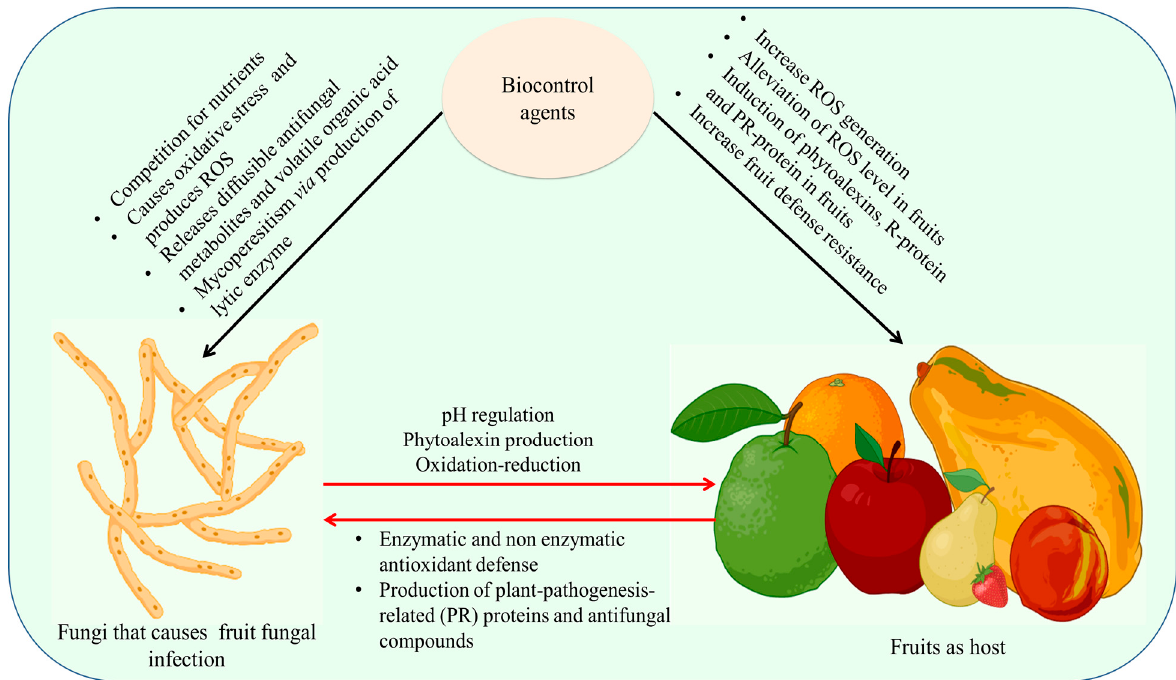
Figure 5. Mechanism of biocontrol mechanism in fruit and pathogen. The biocontrol agents affect fungal pathogens by causing oxidative stress that triggers ROS, releases diffusible antifungal me- tabolites and volatile organic acid and Mycoperesitism via the production of lytic enzyme. In fruits, increase ROS generation, induction of phytoalexins, R-protein, and PR-protein in fruits led to an increase in fruit defense resistance by antioxidant enzymes. Figure created with BioRender.com (https://app.biorender.com/biorender ‒ templates)—accessed on 25 November 2022.